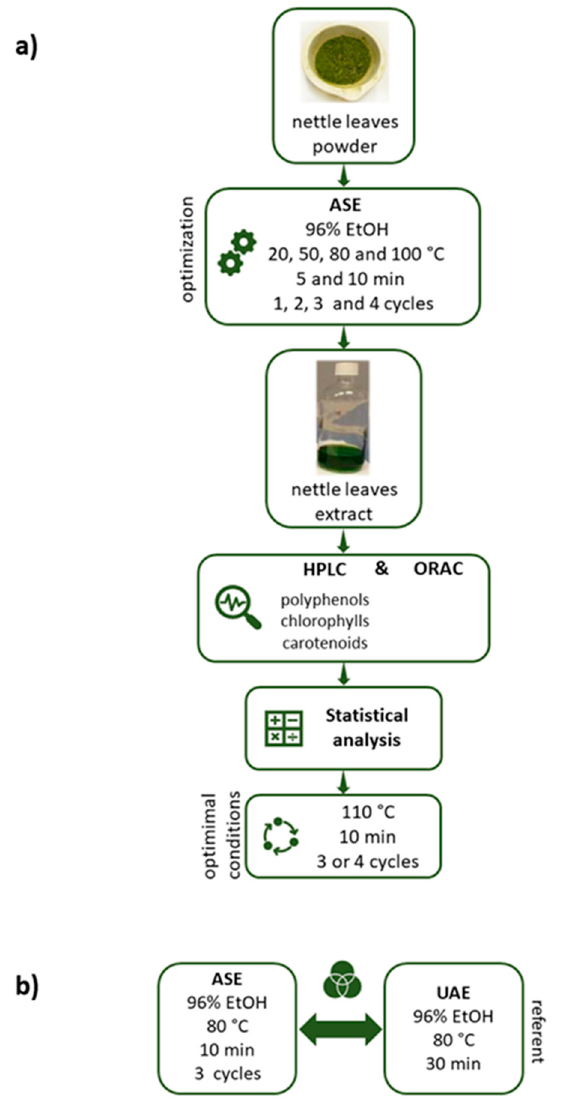
Figure 1. Experimental setup: ( a ) optimization of ASE conditions, ( b ) comparison of ASE and UAE efficiency. ( ASE = accelerated solvent extraction, UAE = ultrasound assisted extraction)